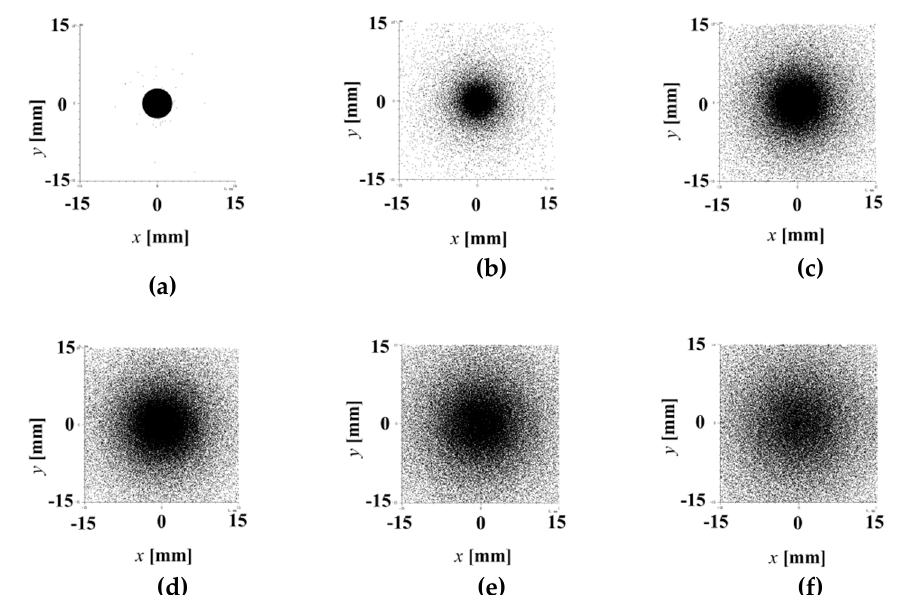
Figure 5. Simulated ray distribution of the PMMA homogenous spherical lens at the focal plane length f : f = ( a ) 15 mm, ( b ) 18 mm, ( c ) 24 mm, ( d ) 30 mm, ( e ) 36 mm, and ( f ) 42 mm.